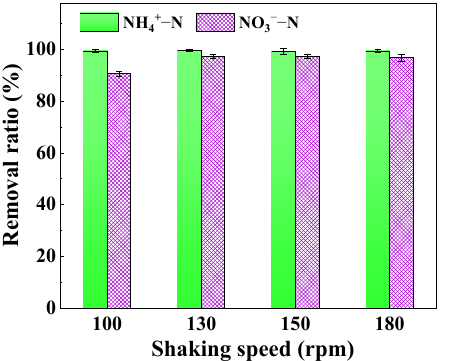
Figure 8. Influence of shaking speed on nitrogen compounds removal on Vibrio sp. LY1024.